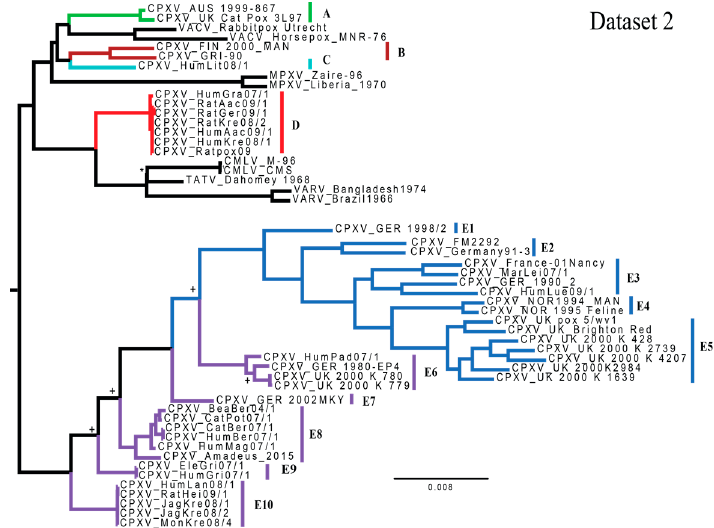
Figure 2. A majority-rule consensus tree generated from the MrBayes analysis of dataset 2 (95,410 bp). All BPP values were ≥ 0.95 unless otherwise noted by the following symbols: * (BPP = 0.5657) and + (BPP = 0.8424). Scale bar indicates the number of mutations per site. Clades are colored in the same manner as Dabrowski et al. [26]. Outgroup is not pictured.